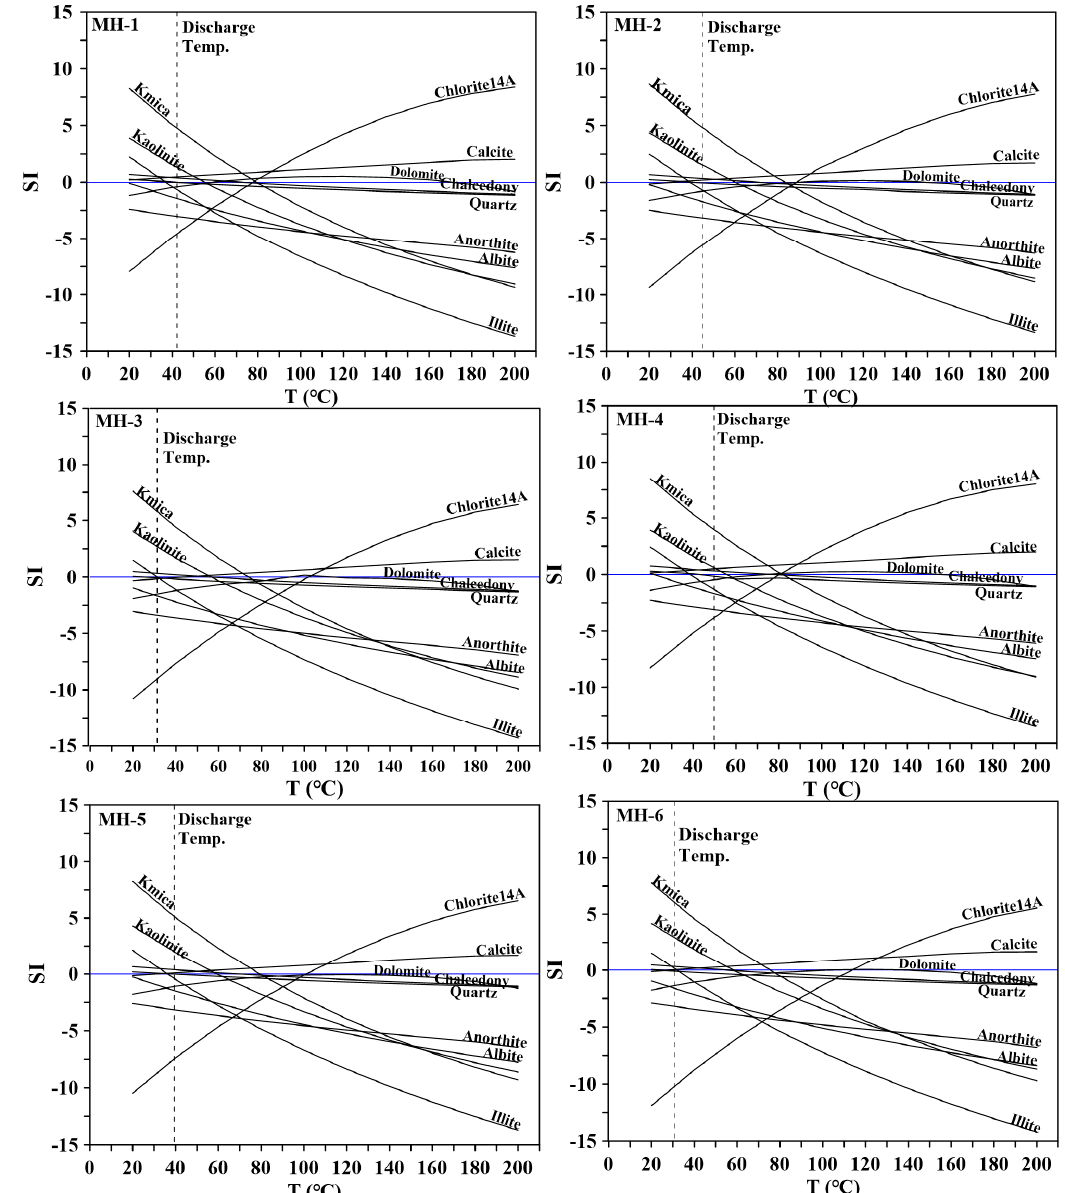
Figure 14. Changes in saturation indices of thermal waters with respect to potential reactive minerals, as a function of temperature.